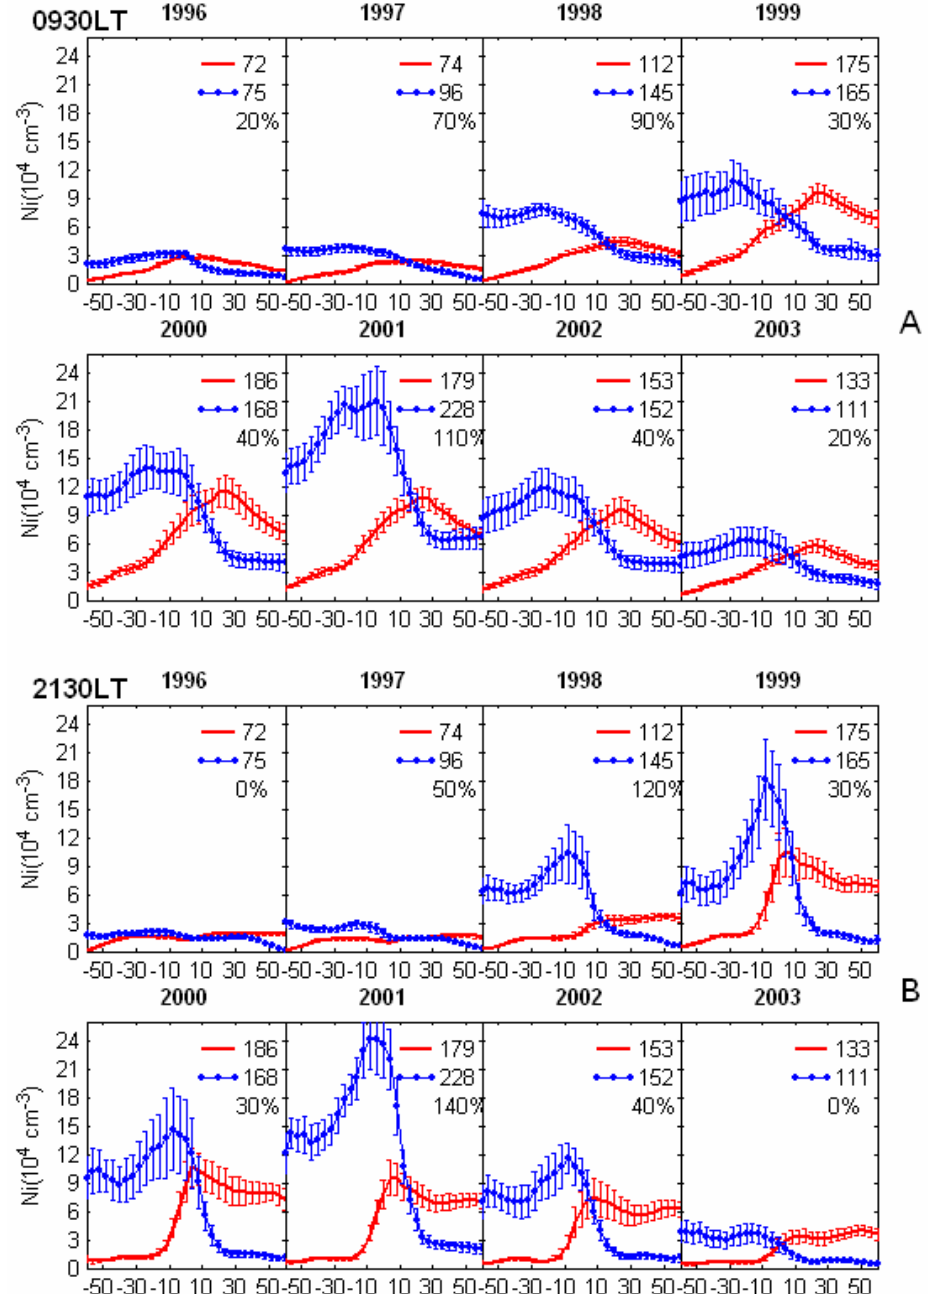
Figure 7. Latitudinal variations of the average observed electron density during June solstice (solid curves) and December solstice (dotted curves). A is for 0930 LT and B for 2130 LT.